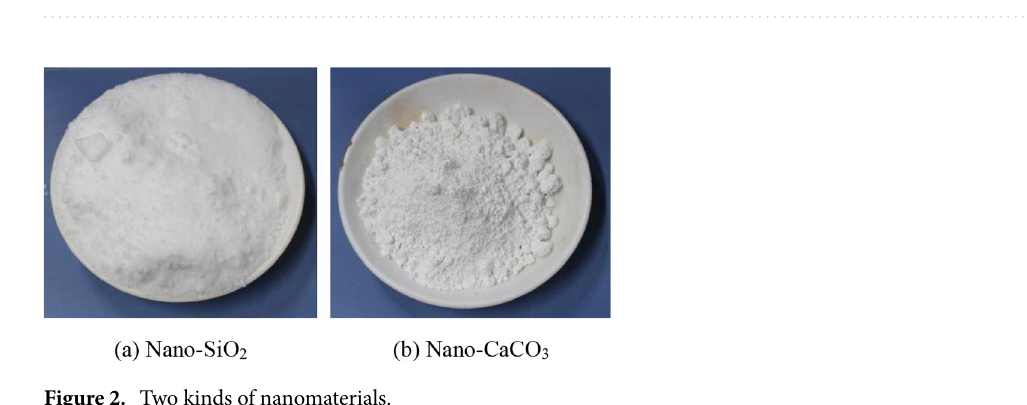
Table 3. Main performance indexes of mother liquor for high performance water-reducing agent of polycarboxylates.